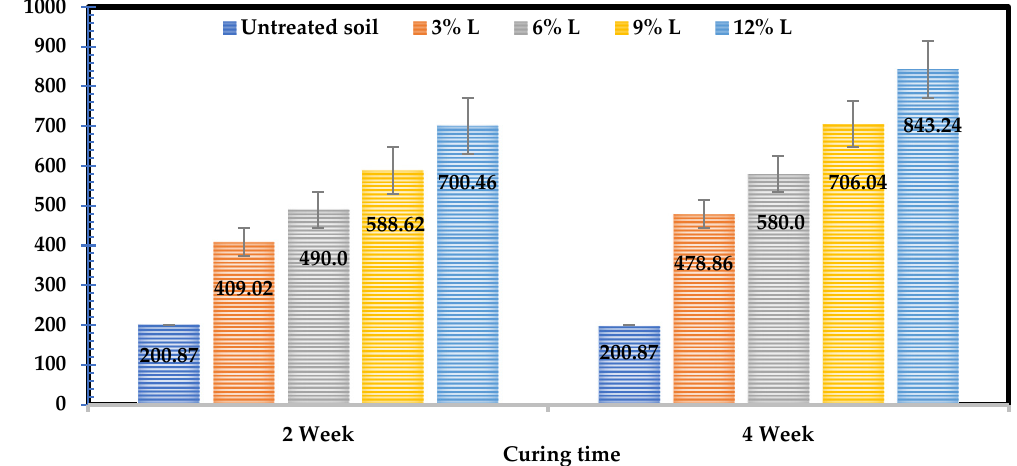
Figure 6. The compressive strength value for different lime contents.